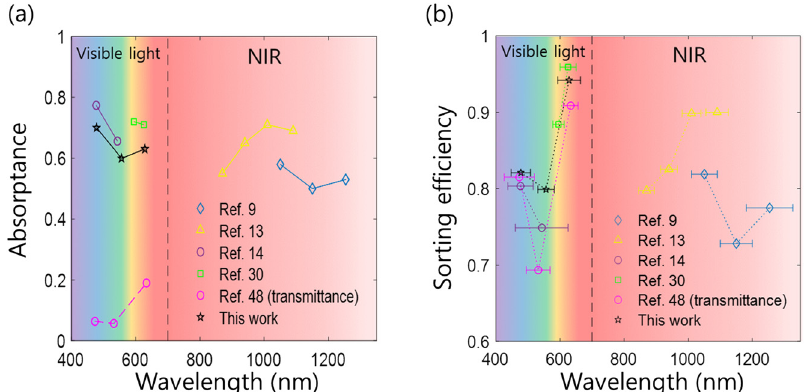
Figure 6: (a) Absorptance of this work and previous works on subwavelength photon sorting using metasurfaces based on plasmonic resonance (blue symbol) [9], multi-junction absorber (yellow) [13], sub- wavelength grating (purple) [14], anti-Her- mitian coupling (green) [30], and holographic diffraction (magenta) [48]. (b) Sorting ef fi ciency and full width at half maximum(FWHM)ofthisworkandprevious works. The sorting ef fi ciency is de fi ned as the ratio of the absorbed power in the target nanostructure to the total absorbed = P / P power, i.e., η target total s